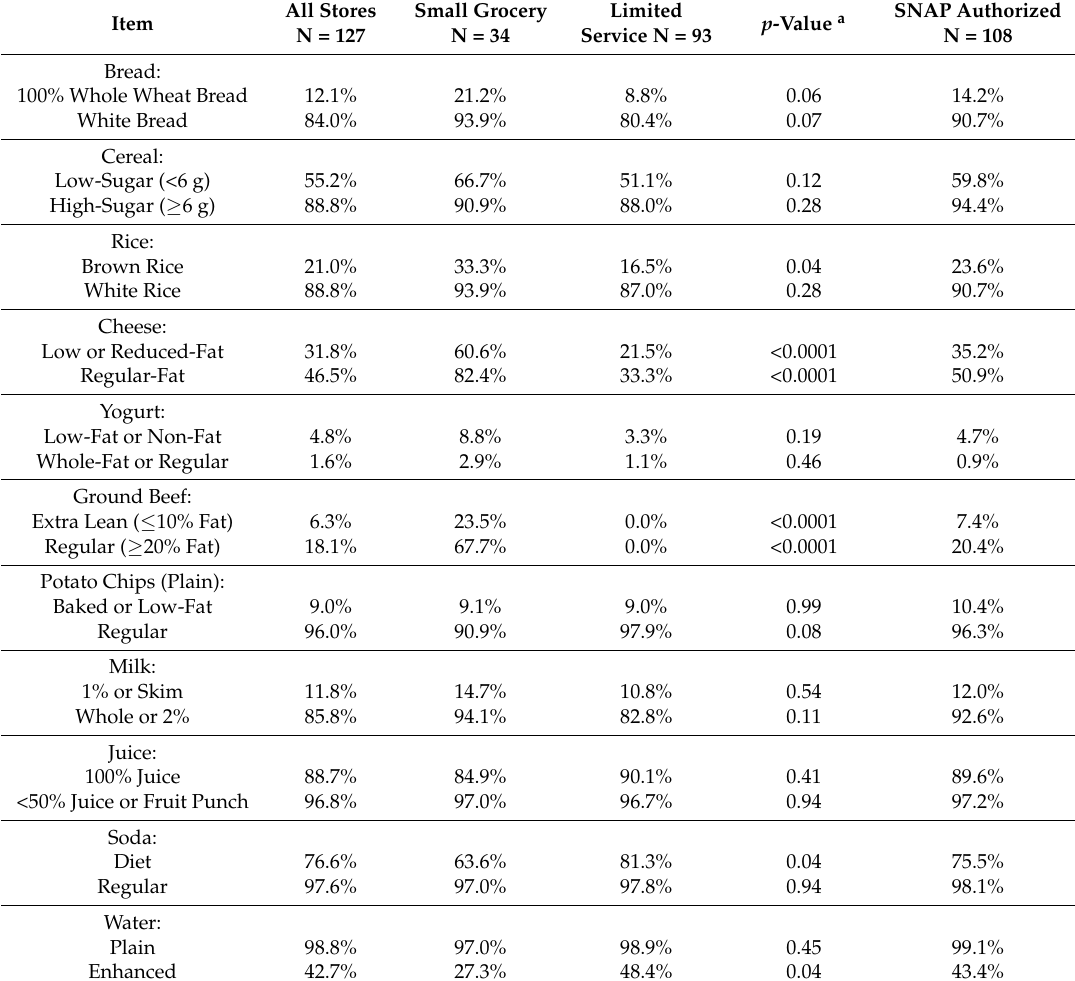
Table 3. Food and beverage availability in food stores stratified by store type,